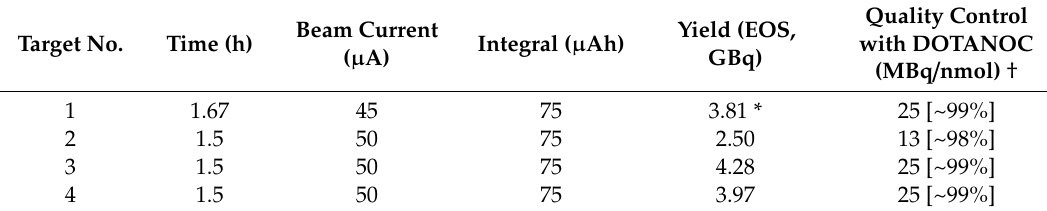
Table 1. Irradiation of a selection of 44 CaO targets (6 mm × 0.5 mm; ~30 mg) using a degraded 72 MeV proton beam at PSI.